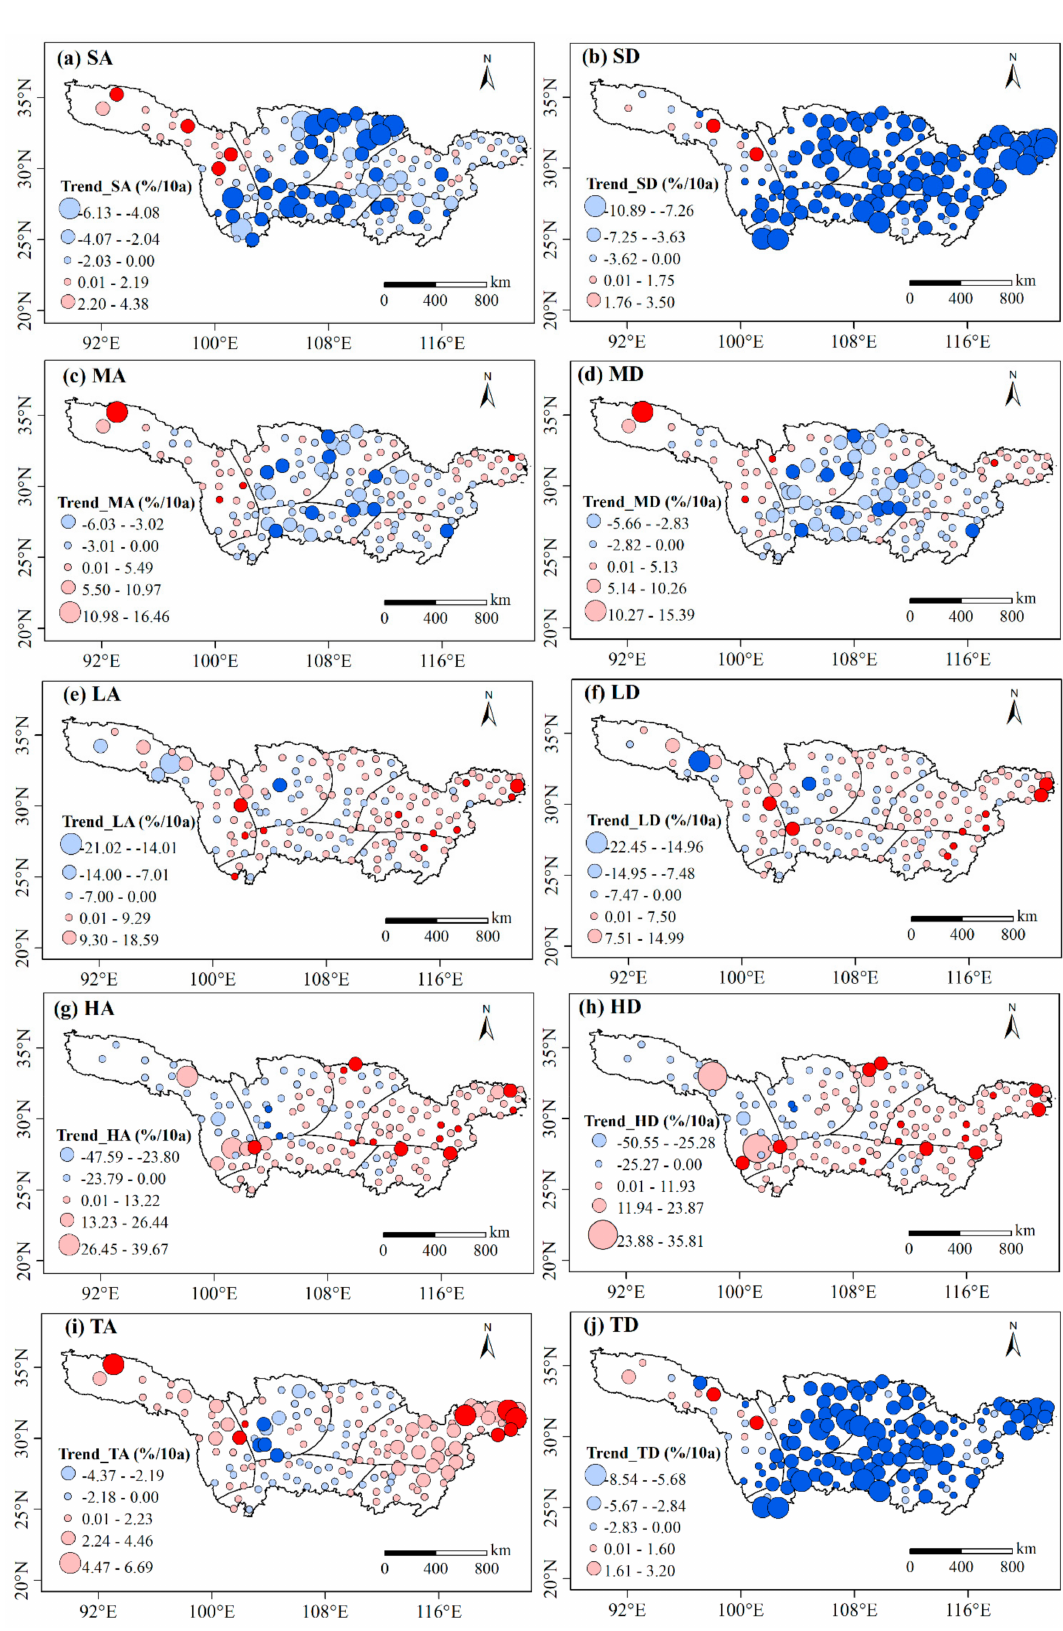
Figure 3. Spatial variations in different grades of precipitation amounts and frequencies ( a – j ) over the YRB from 1960–2017. The trend is expressed as a percentage of the average precipitation amount (frequency) per decade. A red (blue) spot represents a station showing an increasing (decreasing) tendency. Dark red (blue) represents a significant increase (decrease) at the 0.05 confidence